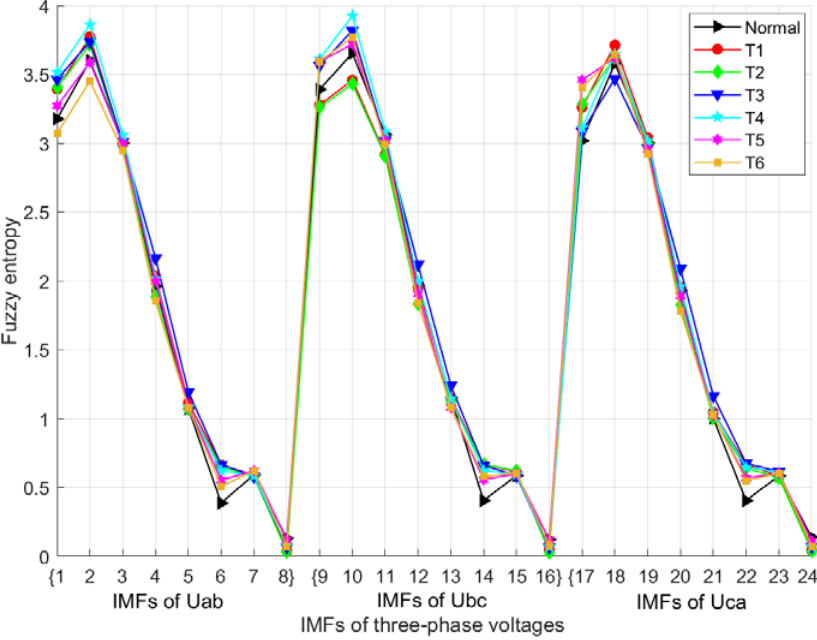
Figure 5. The fuzzy entropy of the MEMD-IMFs of three-phase voltages in different fault modes.